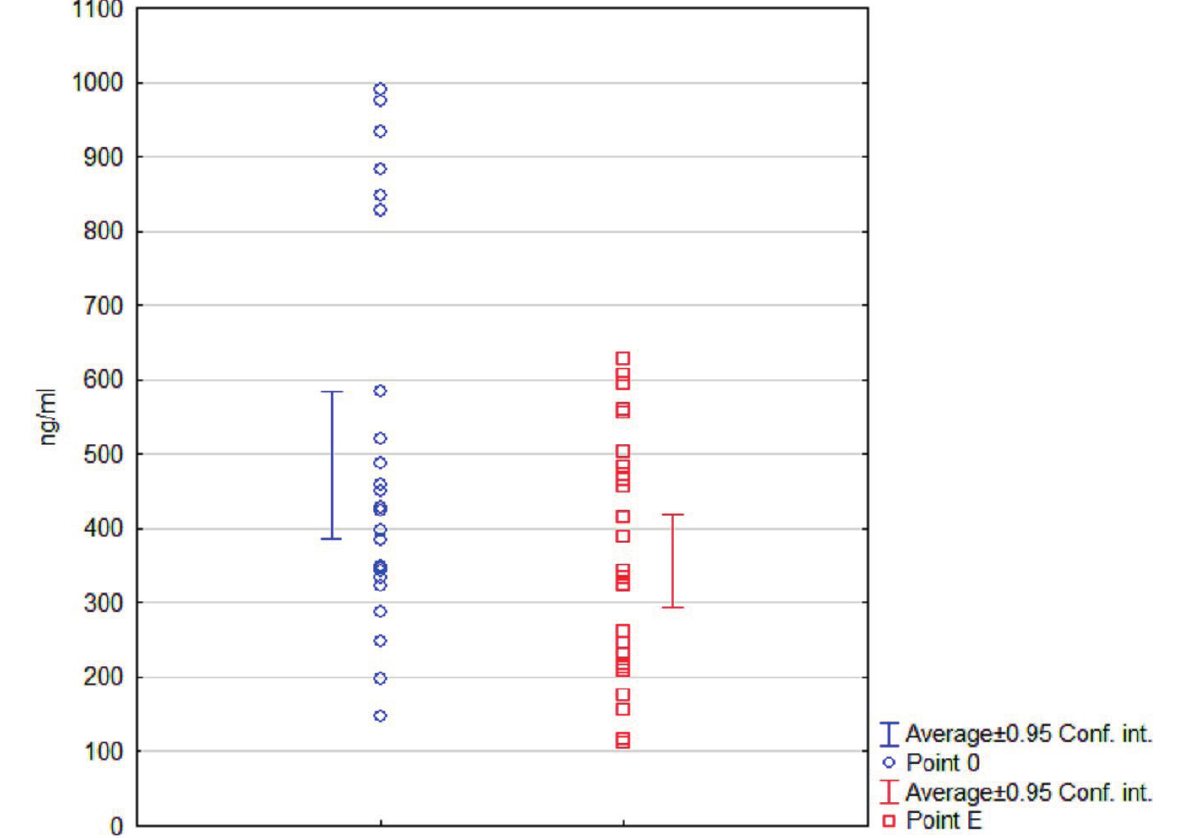
Fig. 2 Scatter plot with 95% confidence interval showing the average concentration of MMP-9 among sex-code 1 patients at two points in